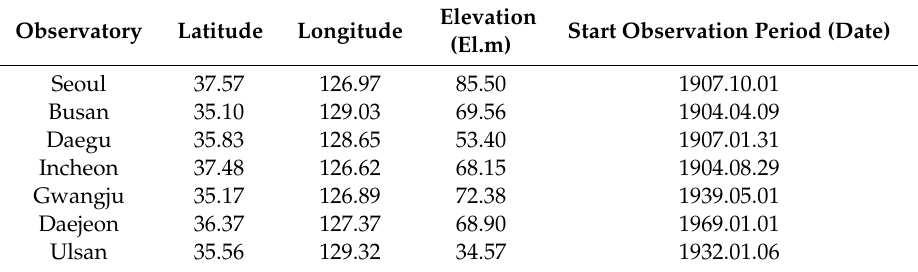
Table 3. Characteristics of rainfall observatories in the target regions.